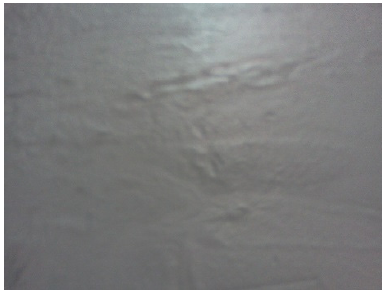
Figure 6. Shape of the discharging compressed air foam of specimen II.